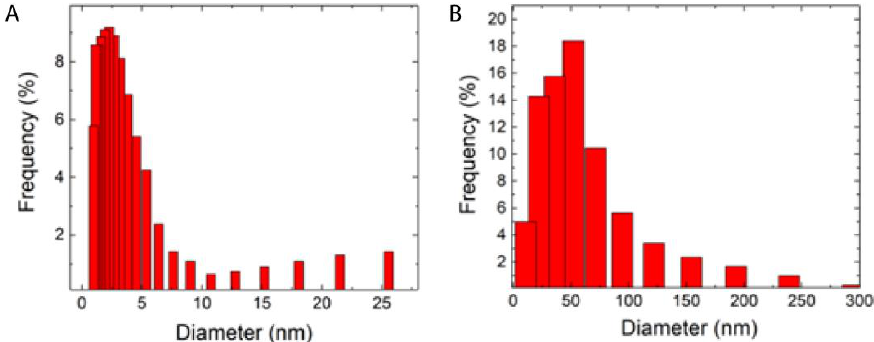
Figure 3. Dynamic Light Scattering (DLS) data for the characterization of AuNPs synthesized by Pulsed Laser Ablation in Liquids (PLAL) presented in number mode. The average diameters were 2 nm for AuNP-1 ( A ) and 53 nm for AuNP-2 ( B ).